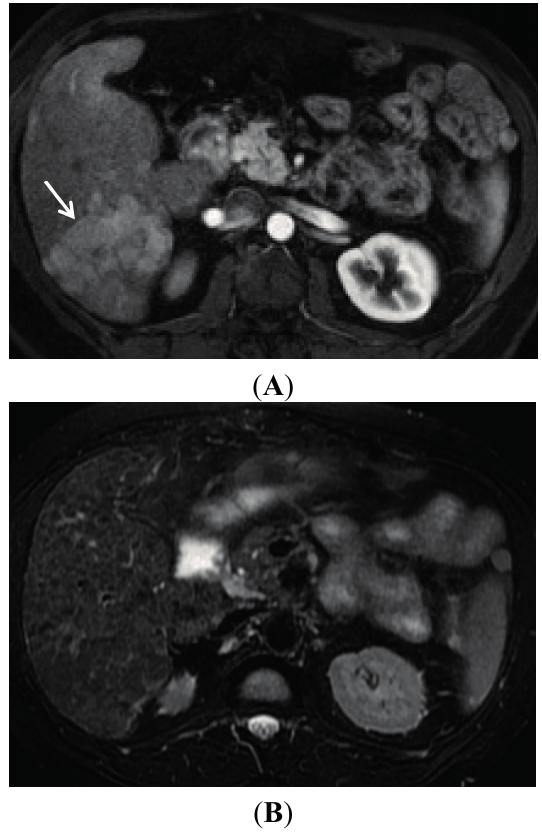
Figure 6. The potential unreliable display of HCC on T2W imaging. ( A ) A late arterial